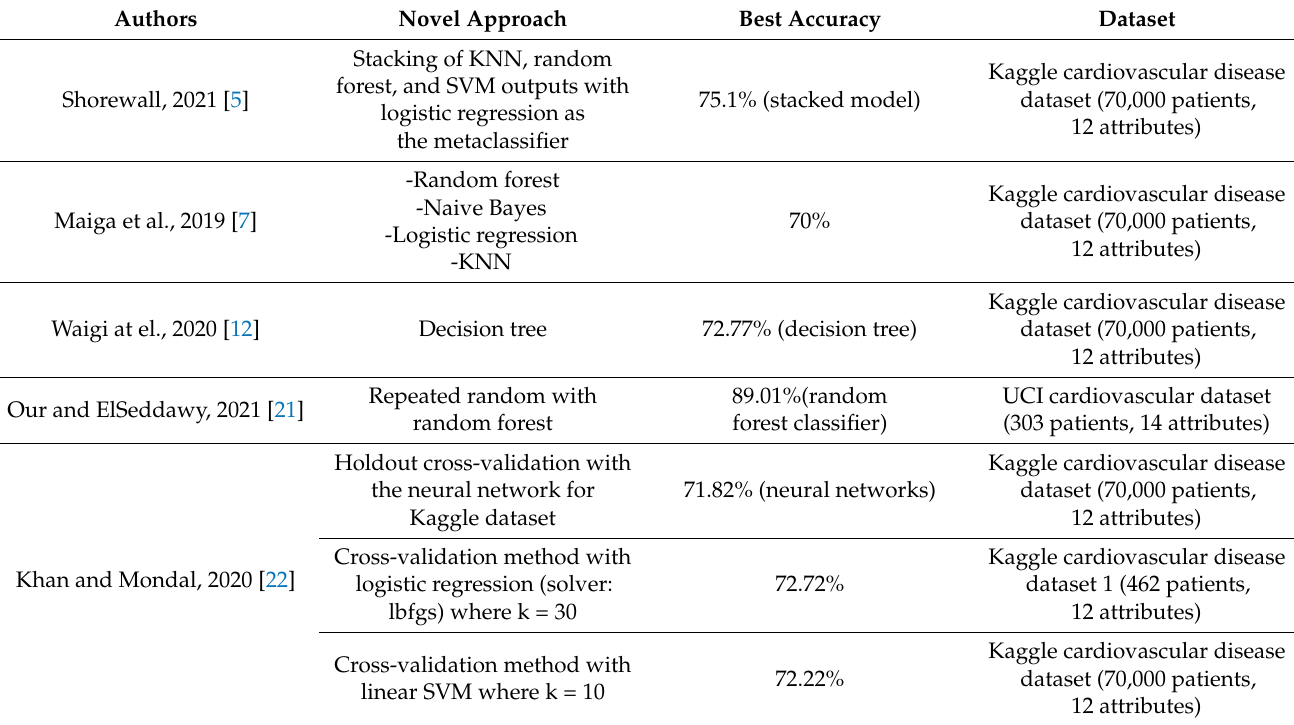
Table 1. Related work on heart disease prediction using large